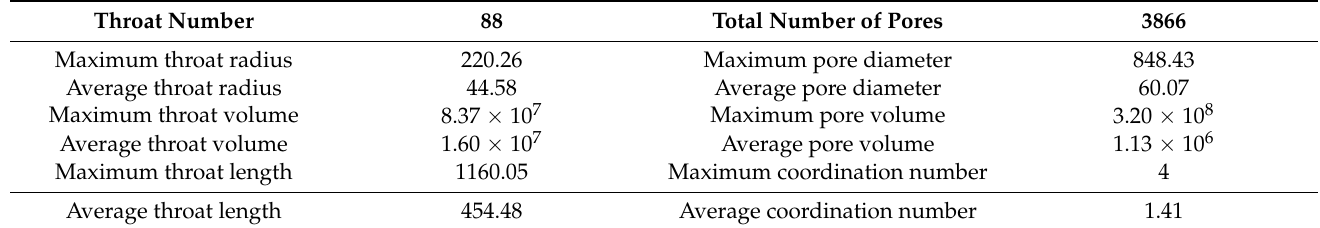
Table 4. Pore network parameters (unit, volume: ml; radius: